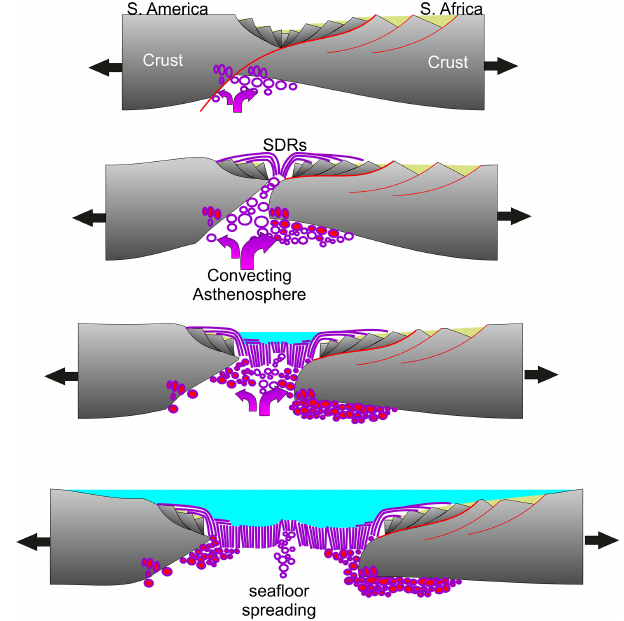
Figure 10. Conceptual model for the asymmetric emplacement of the HVLC in a simple-shear rift setting. According to the litho- spheric model, extension is accomplished by displacement along a major detachment, resulting in nonuniform extension of crust and mantle lithosphere. Melts will intrude into the continental lower crust and fill the resulting space below. Continued extension and subsidence results in increasing similarities of upper crustal archi- tecture on both margins but the major asymmetry in HVLC will be